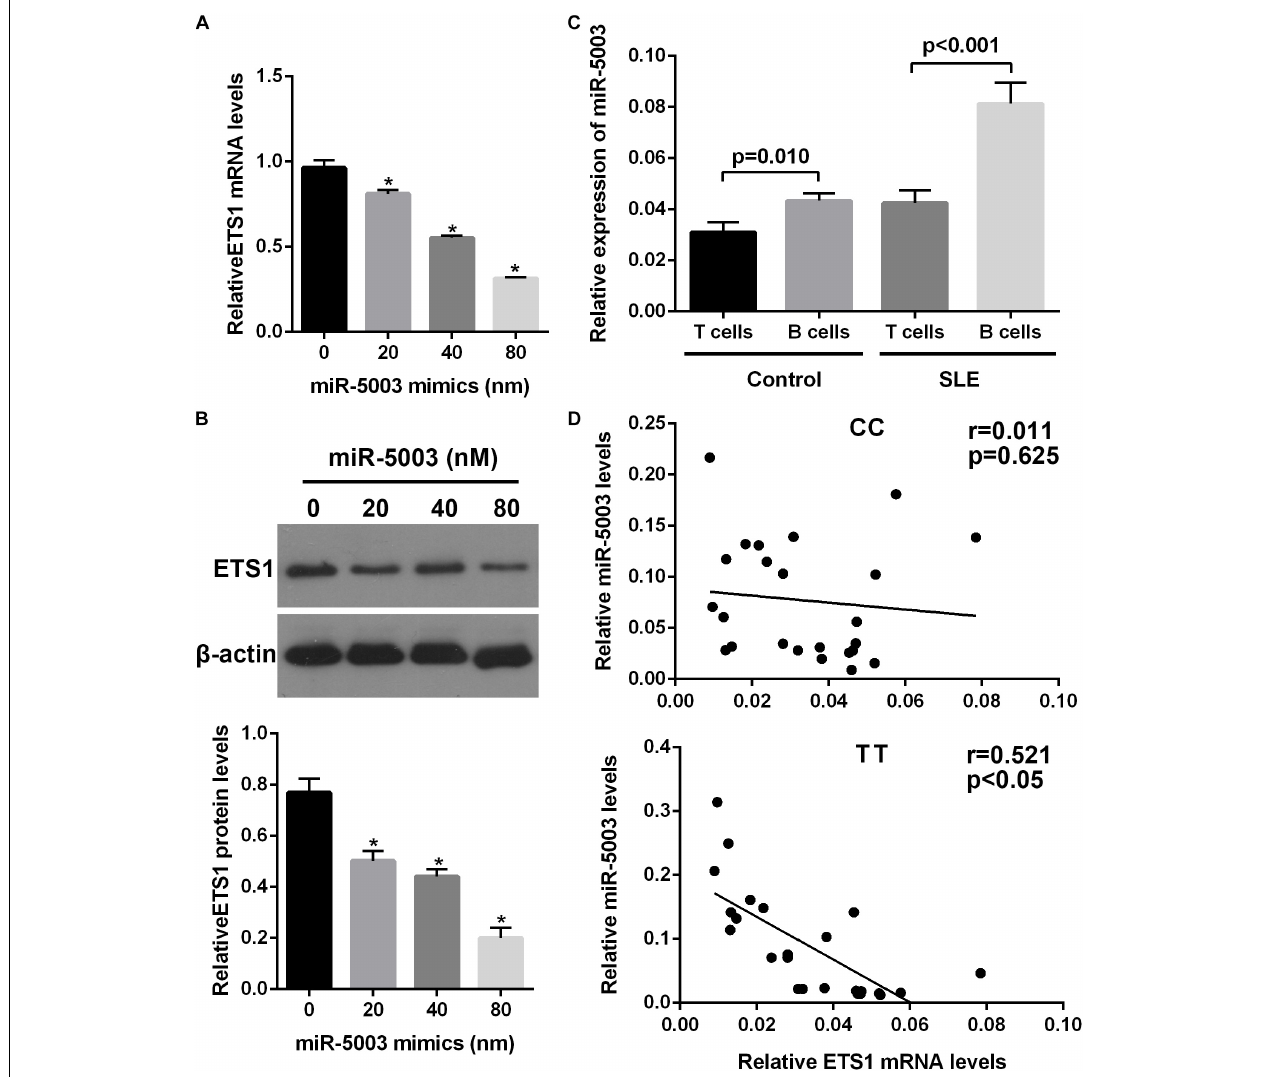
FIGURE 5 | The effect of the variant allele on ETS1 and miR-5003-3p levels. (A) Real-time quantitative polymerase chain reaction (qPCR) analysis of relative ETS1 mRNA expression in primary B cells transfected with the miR-5003 mimic at the indicated concentrations. (B) Western blot analysis of endogenous ETS1 in primary B cells transfected with miR-5003-3p mimic at the indicated concentrations. (C) miR-5003 levels in B cells or T cells of SLE patients and controls. (D) Correlation analysis of miR-5003 levels and ETS1 mRNA levels in B cells from TT or CC carriers. ∗ P < 0.05 vs. miR-NC; n =